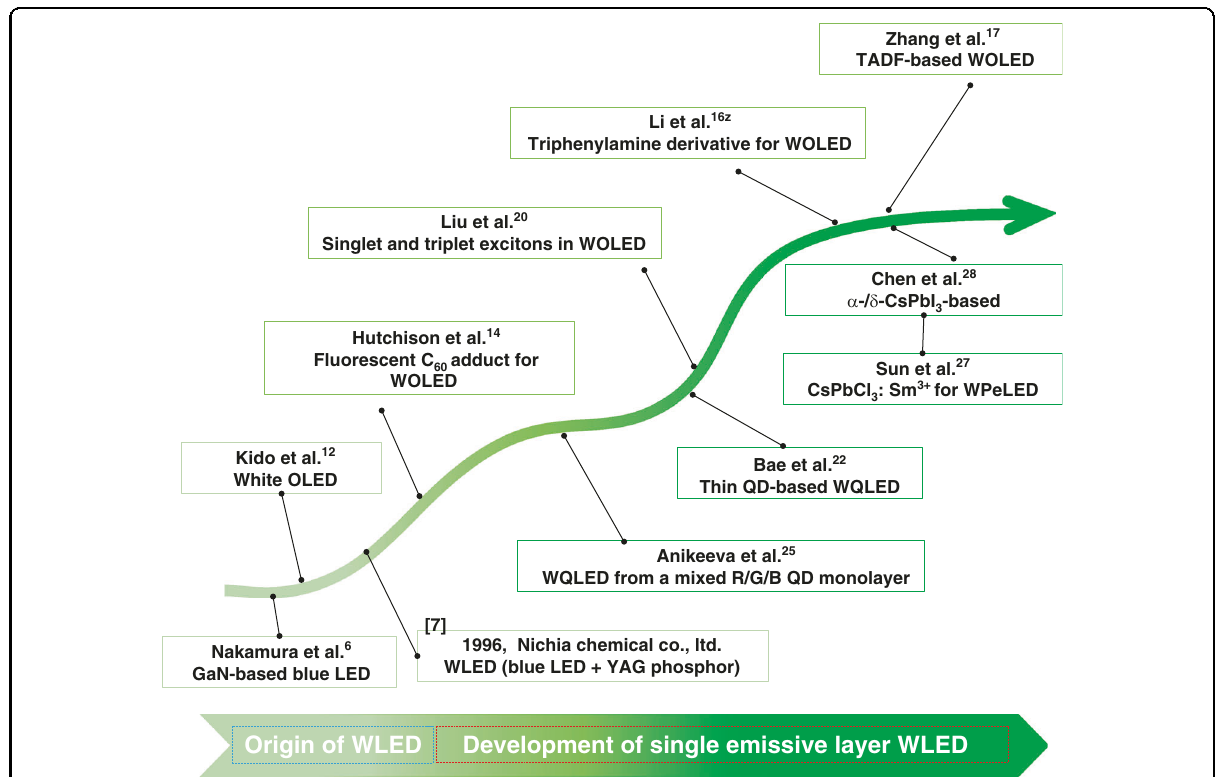
Fig. 1 A brief LED and single emissive layer (SEL) WLED